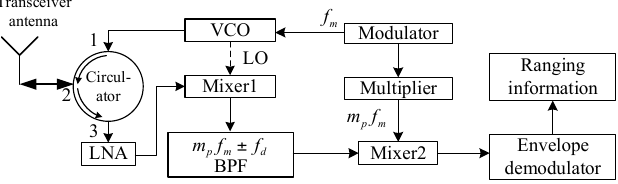
Figure 1. Block diagram of a short-range FMCW proximity sensor (LNA: low-noise amplifier; VCO: voltage-controlled oscillator; LO: local signal).